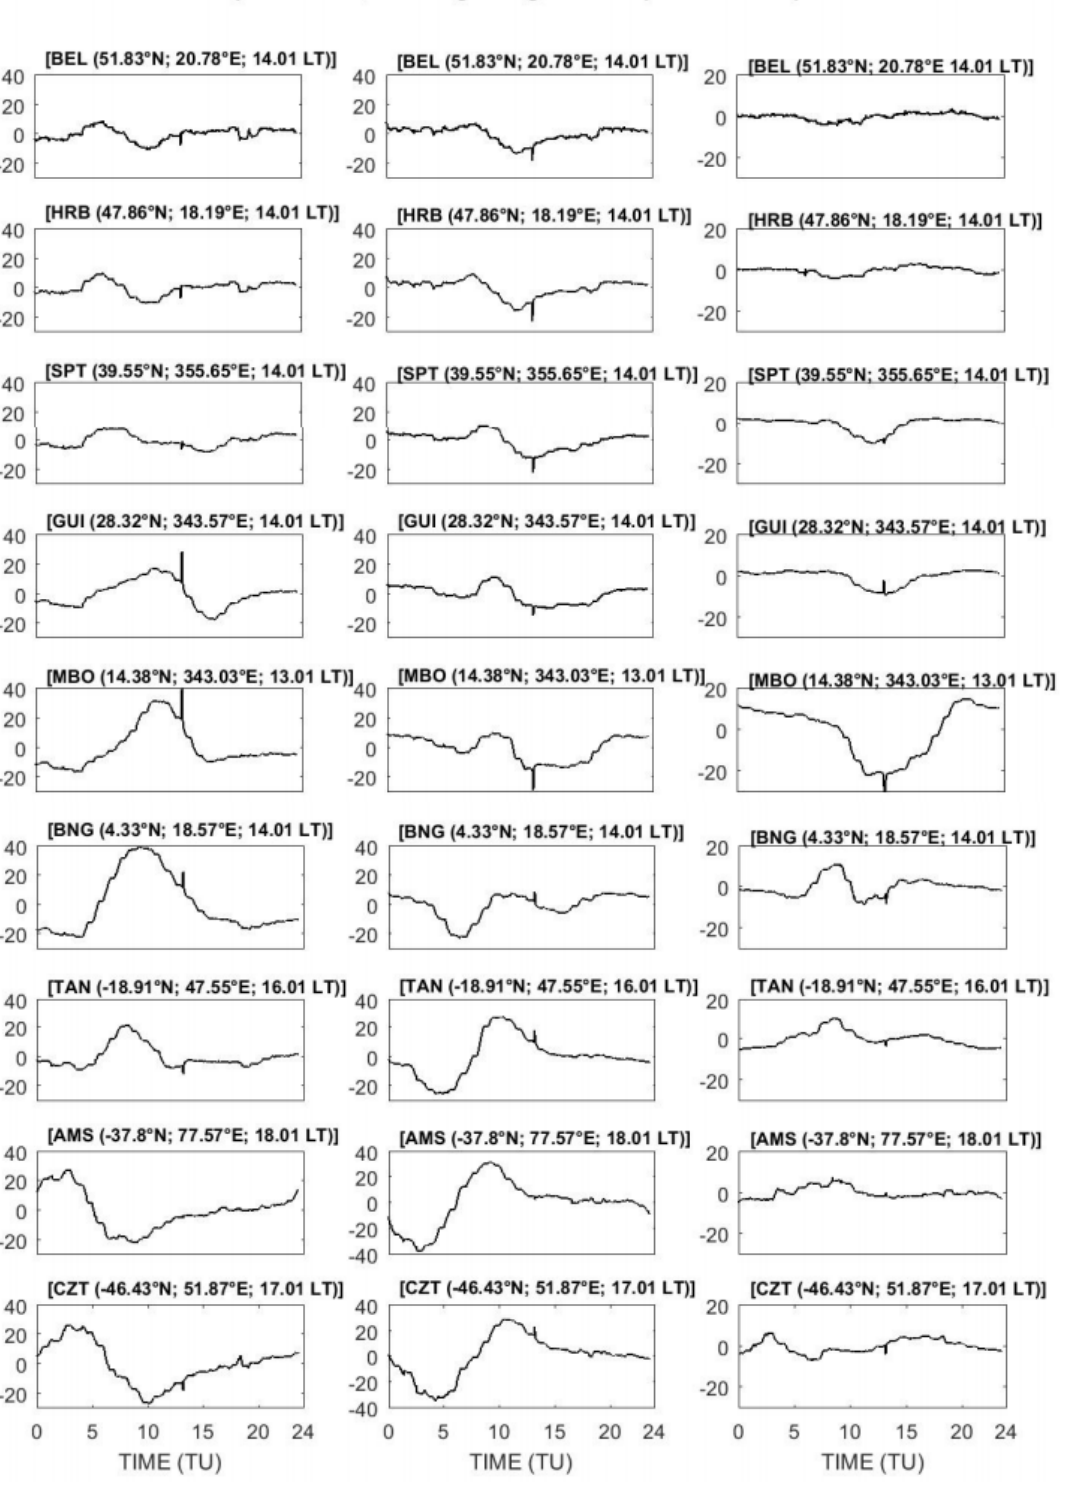
Figure 5. Latitude variation of horizontal (H), eastward (Y), and vertical (Z) components of the geomagnetic field during the X2.6 solar flare of 27 November 1997.